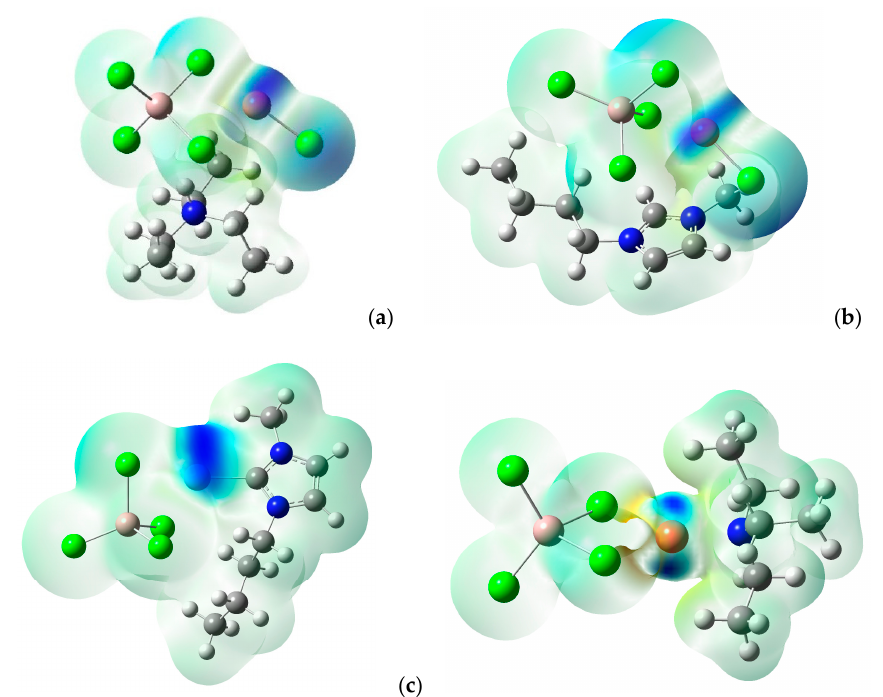
Figure 4. Electron donor Fukui function f − electron-density isosurface plot at 0.004 a.u: ( a ) [(C 2 H 5 ) 3 NH] + [CuAlCl 5 ] − ; ( b ) [C 4 mim] + [CuAlCl 5 ] − ; ( c ) [C 4 mimAg] + [AlCl 4 ] − ; ( d ) [(C 2 H 5 ) 3 NCu] + [AlCl 4 ] − ; the blue color around Cu or Ag indicates that the transition metal atom is a favorite site for accepting the electrophilic